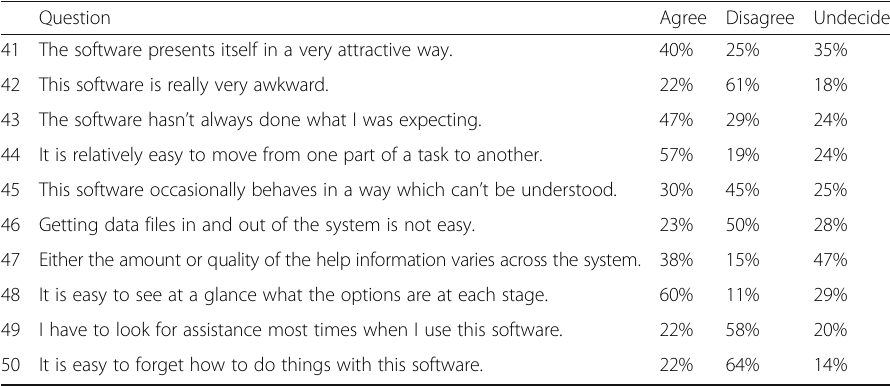
Table 6 Questions 41 – 50 on learnability